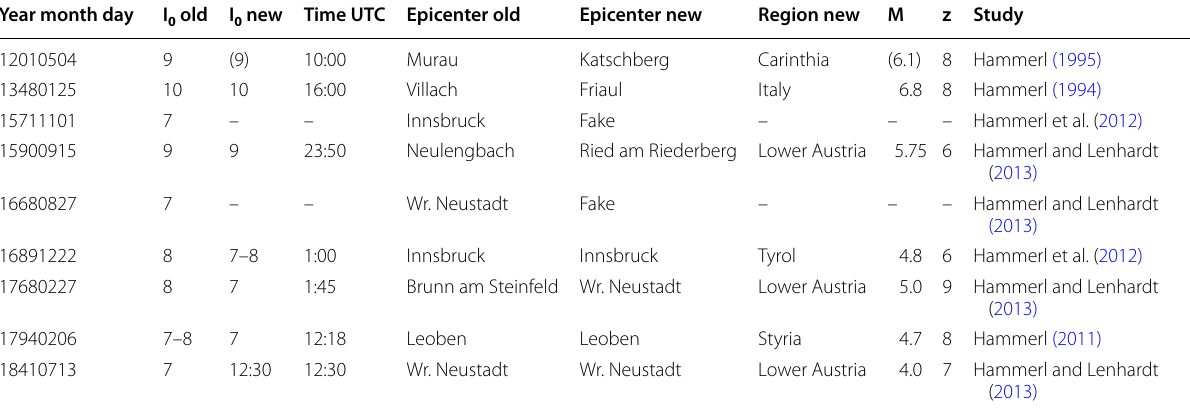
I 0 epicentral intensity, M magnitude, z focal depth in